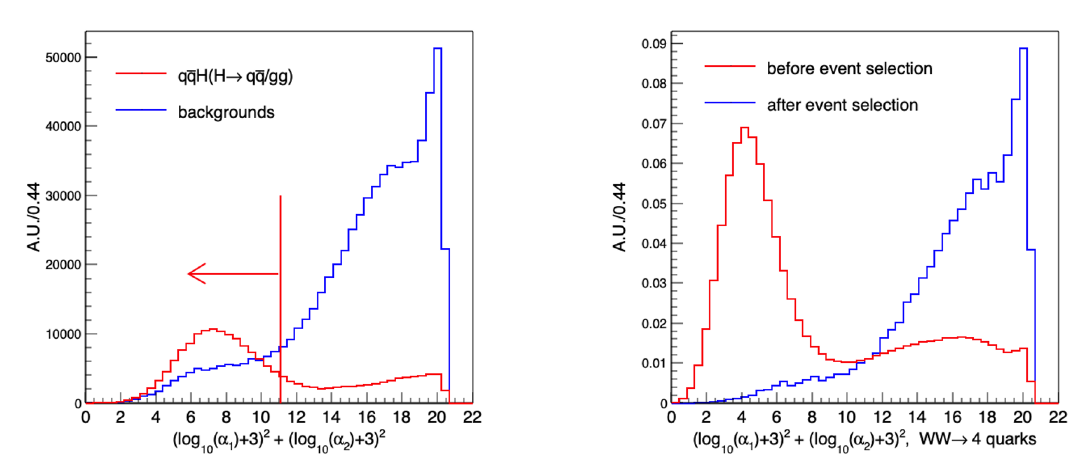
Figure 15 . The distributions of ( log 10 ( α 1 ) + 3) 2 + ( log 10 ( α 2 ) + 3) 2 . The left plot corresponds to the signal and backgrounds after the whole event selection in table 2. The right plot corresponds to the e + e − → W + W − → 4 quarks before and after the whole event selection in table 2 to illustrate that the event selection process was able to strongly suppress the backgrounds with good CSI